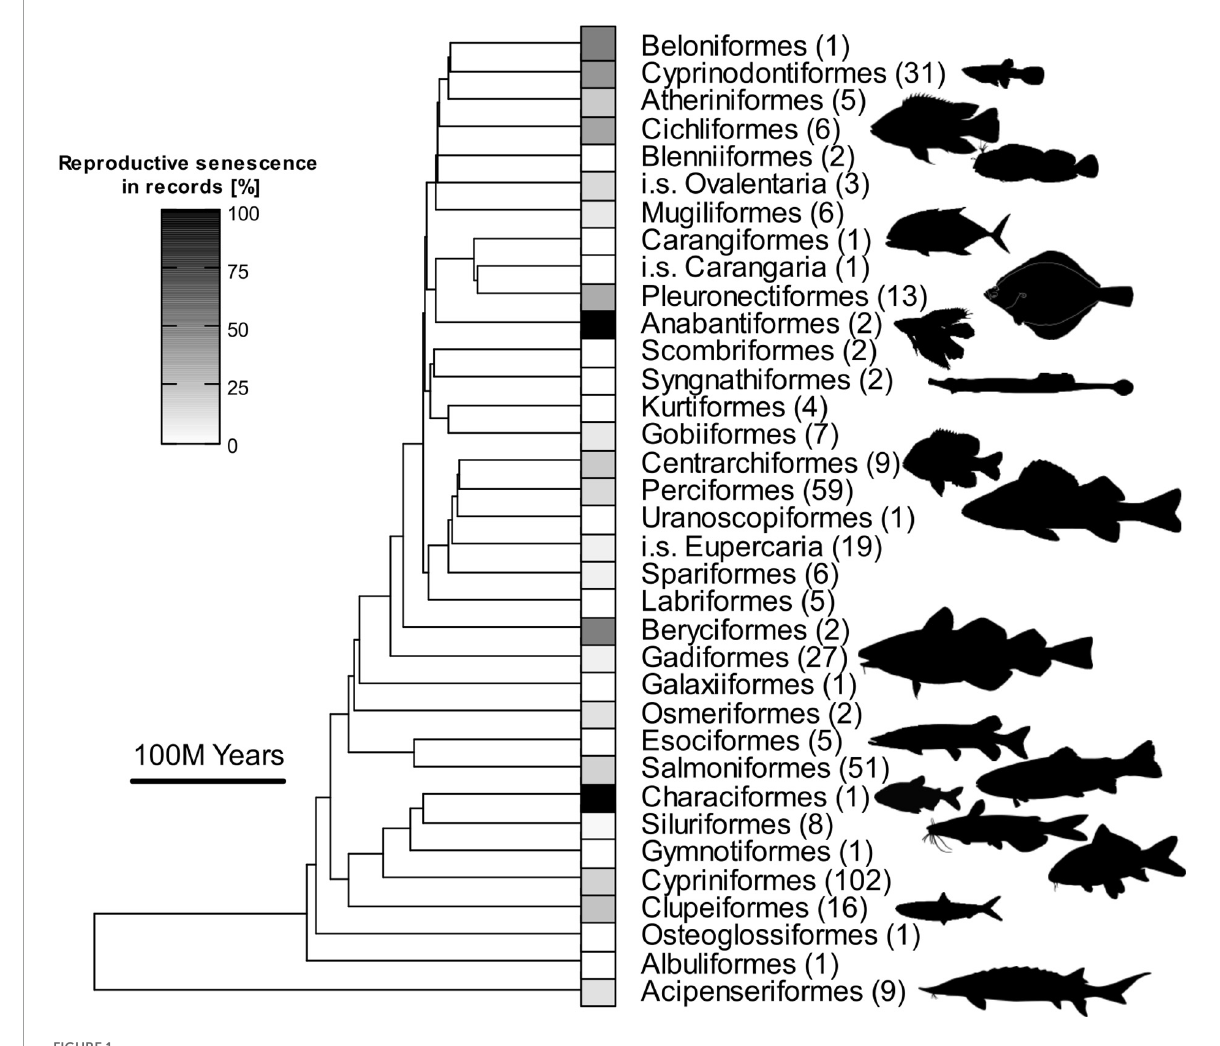
FIGURE1 Records of reproductive senescence across the phylogeny of ray-finned fish (Actinopterygii). More intense black at the tip square points illustrates a higher proportion of negative or bell-shaped relationships between a reproductive trait and age among all the age-reproduction relationships (proportion of reproductive senescence records). The numbers in brackets show the total number of studies for each fish order. Fish silhouettes come from phylopic.org and fishualize R package (https://CRAN.R-project.org/package=fishualize). Please note that only the orders with a record of age effect on reproduction are